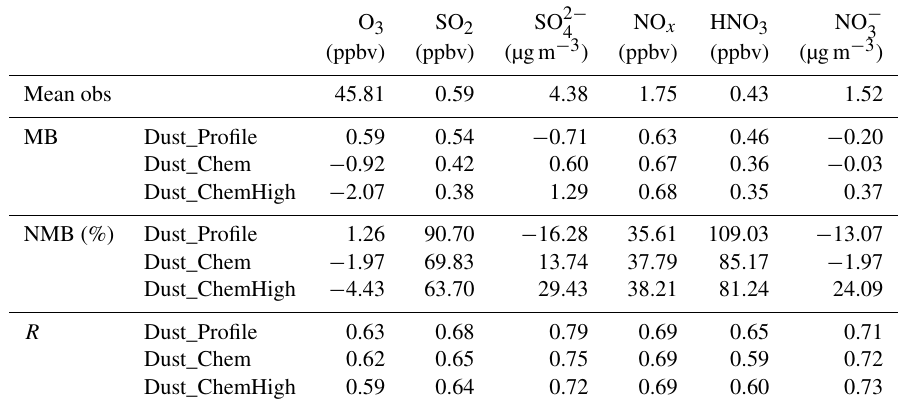
Table 7. CMAQ evaluation against EANET observations for Dust_ Profile, Dust_Chem, and Dust_ChemHigh scenarios for species O 3 , SO 2 , SO 2 − , NO x , HNO 3 , and NO − 4 3